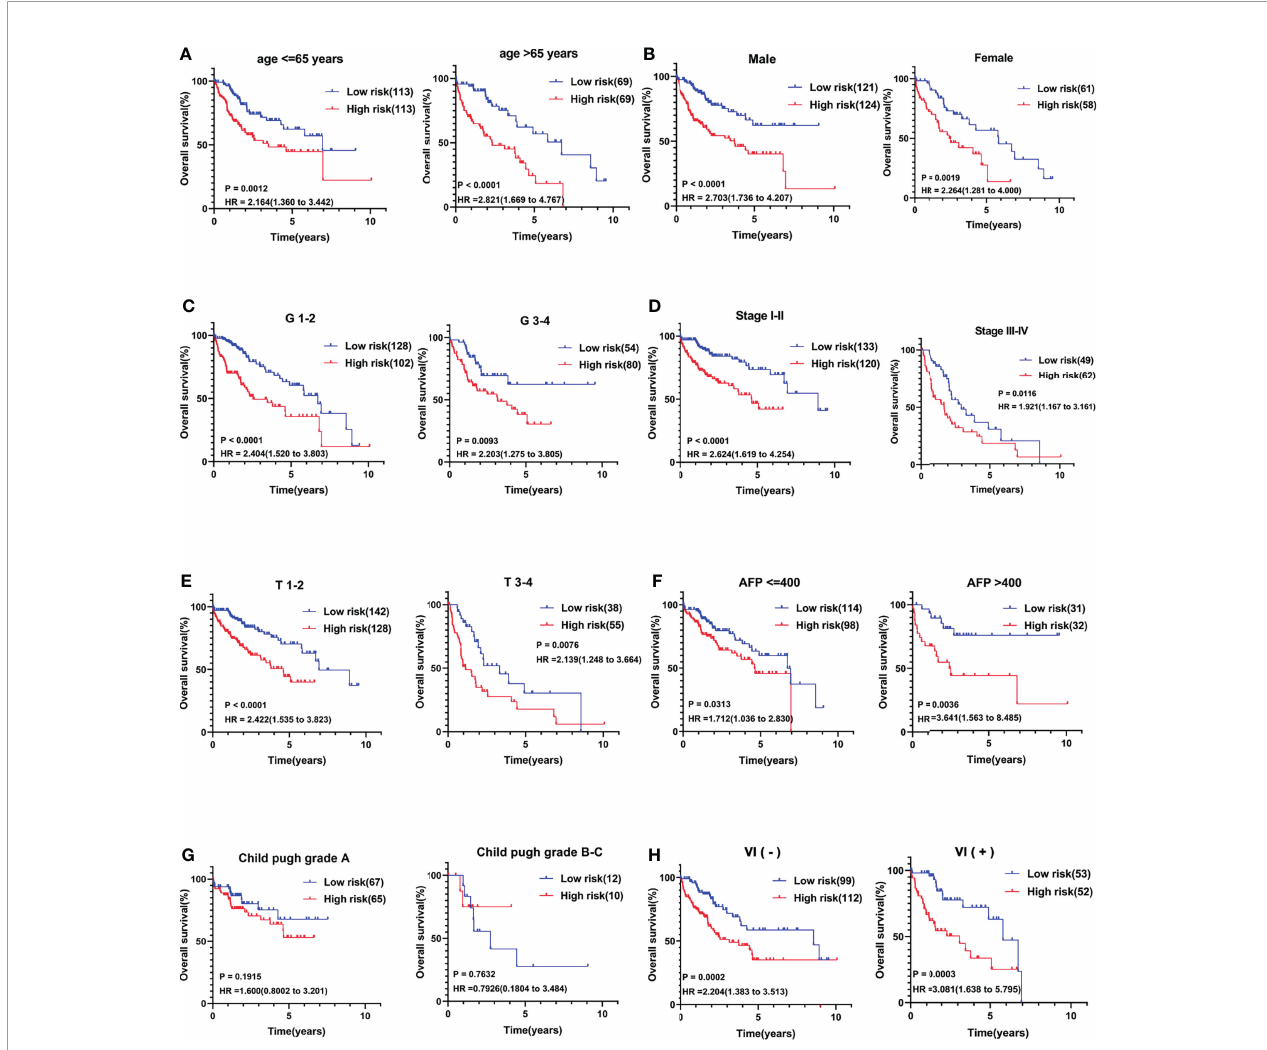
FIGURE 4 | Strati fi cation analysis of several clinical parameters to measure the predictive power of the CCS in each subgroup. Kaplan – Meier curves for association between OS and each subgroup divided by (A) age, (B) gender, (C) grade, (D) AJCC stage, (E) T stage, (F) AFP value, (G) Child – Pugh grade, and (H) vascular invasion (VI) status. OS, overall survival; AJCC stage, American Joint Committee on Cancer